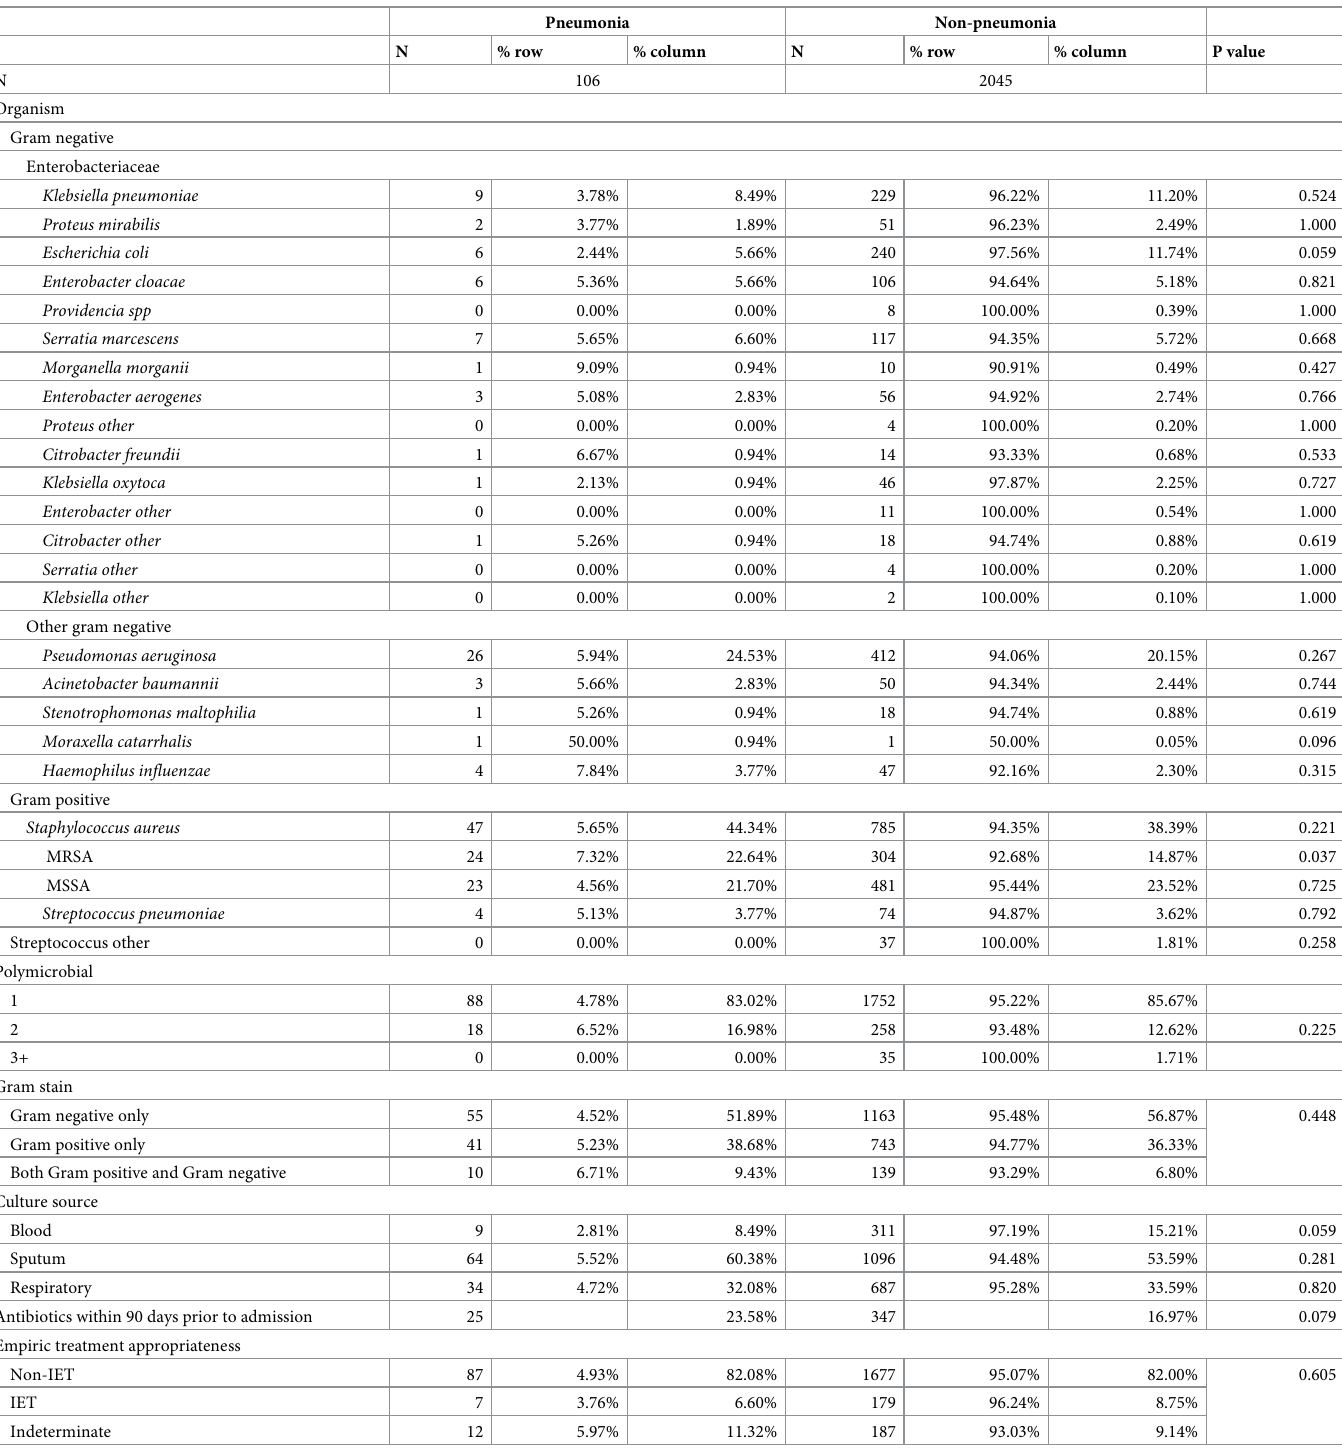
Table 2. Index infection characteristics, treatment, and hospital